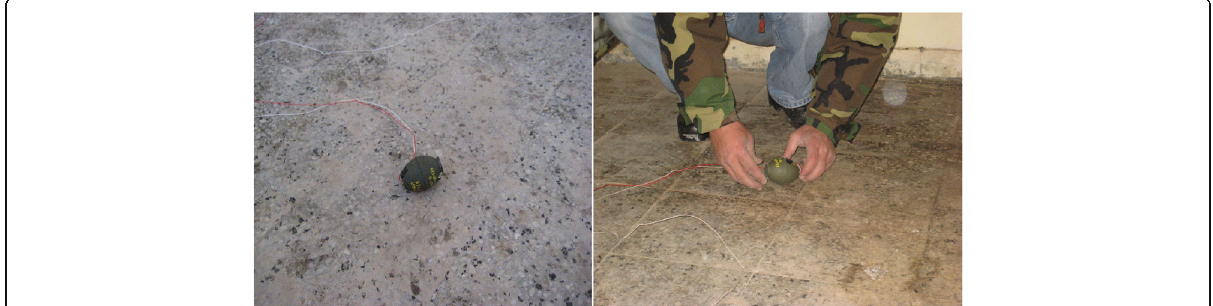
Fig. 10 The two DM-41hand grenades primed in for test